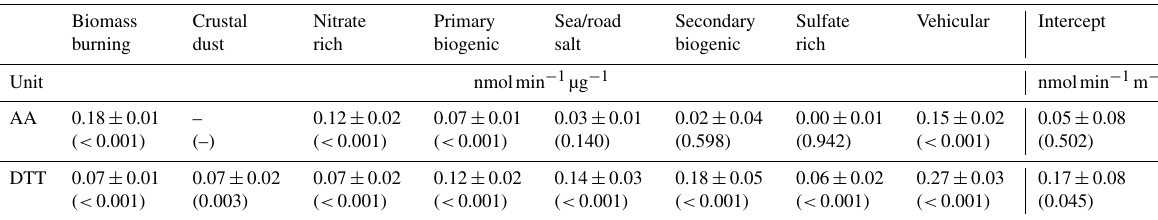
Figure 4. Comparison of the modeled OP (orange) and the observed OP for both the AA (a) and DTT (b) test (85 samples) from November 2013 to November 2014. The black error bars are the standard deviation of the observed values and the shaded orange area the uncertainties of the modeled OP. Units are in OP normalized by volume and expressed in nmolmin − 1 m − 3 . Table 2. Regression coefficients (i.e., intrinsic OP) expressed in nmolmin − 1 µg − 1 at Chamonix for the AA and DTT assays. The values are the mean ± standard deviation based on N = 1000 bootstrap of the best solution. The p -value is in the parenthesis. The crustal dust source was excluded during the inversion process for the AA